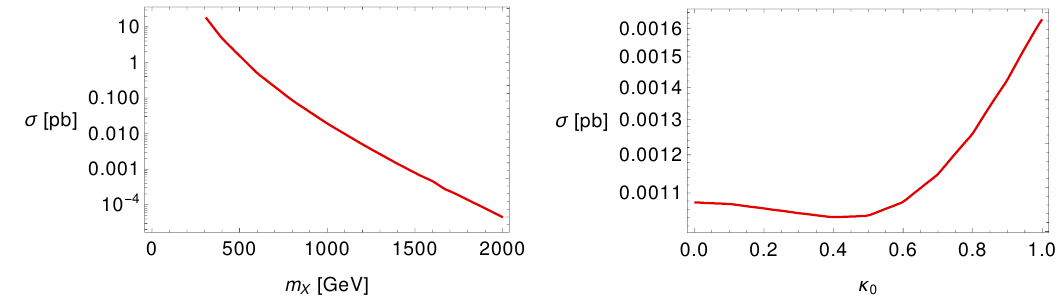
Figure 2. Mediator pair production cross section at the 13 TeV LHC, as a function of the mediator mass m X for fixed κ 0 = 1 (left) and as a function of κ 0 for m X = 1200 GeV